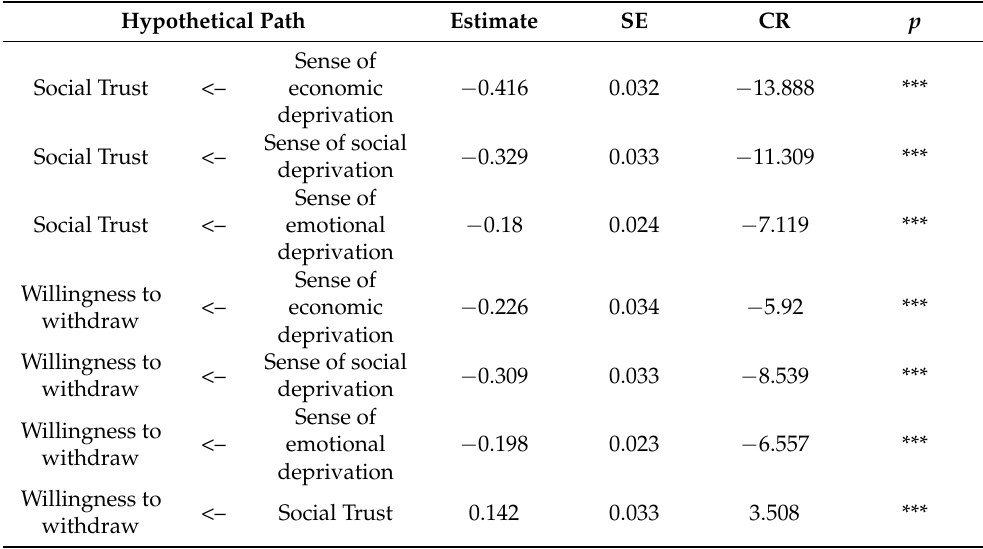
Table 7. Path analysis